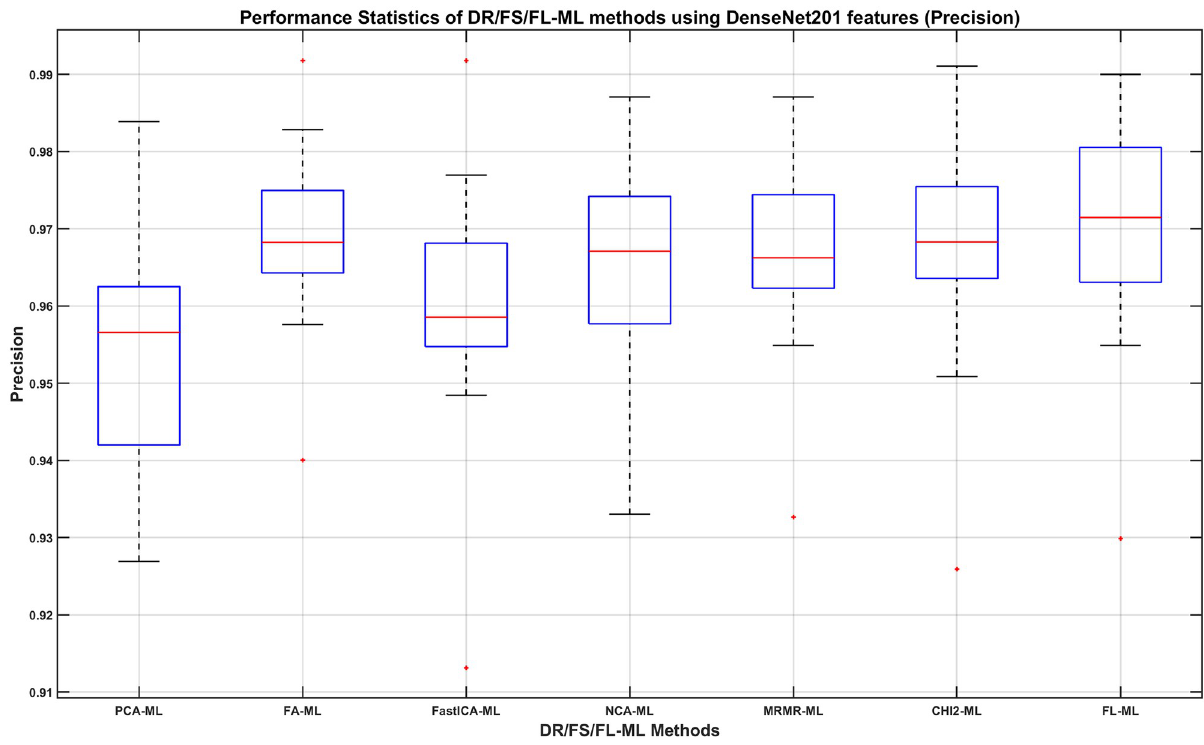
Fig 9. The Precision of DR/FS/FL-ML methods using DenseNet201 features. The ML learners used can be found in the second row of Table 8.